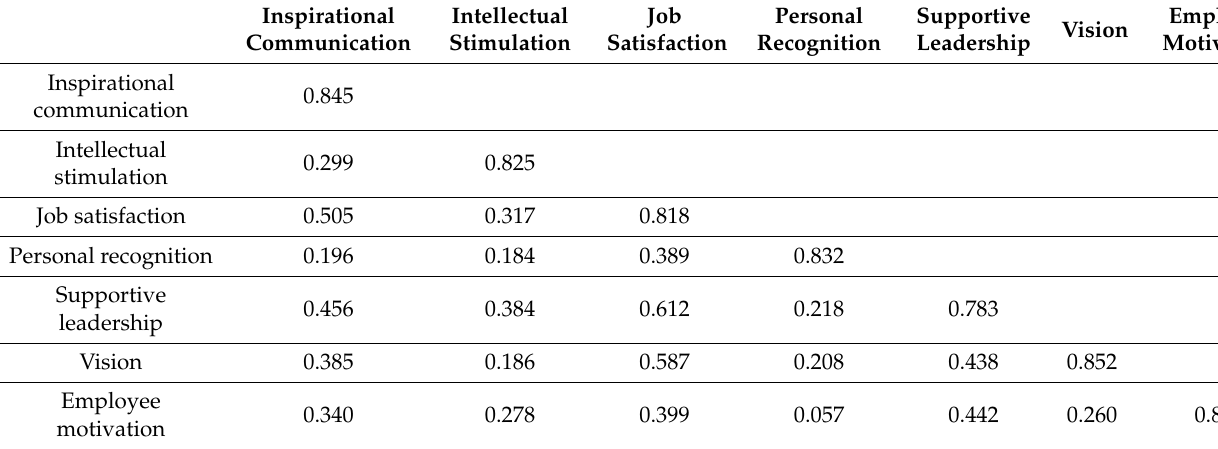
Table 6. Discriminant validity.